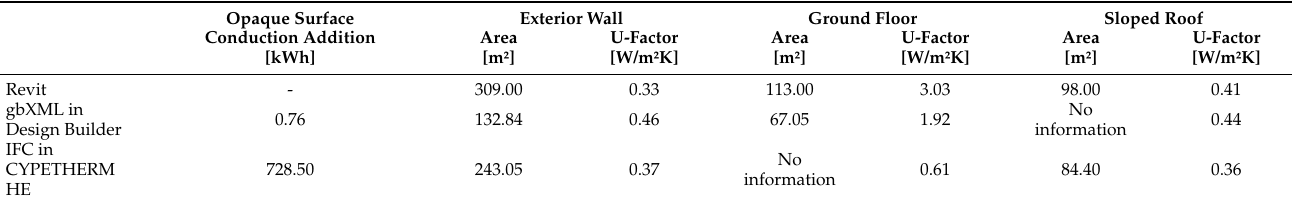
Table 6. Opaque Surface Conduction